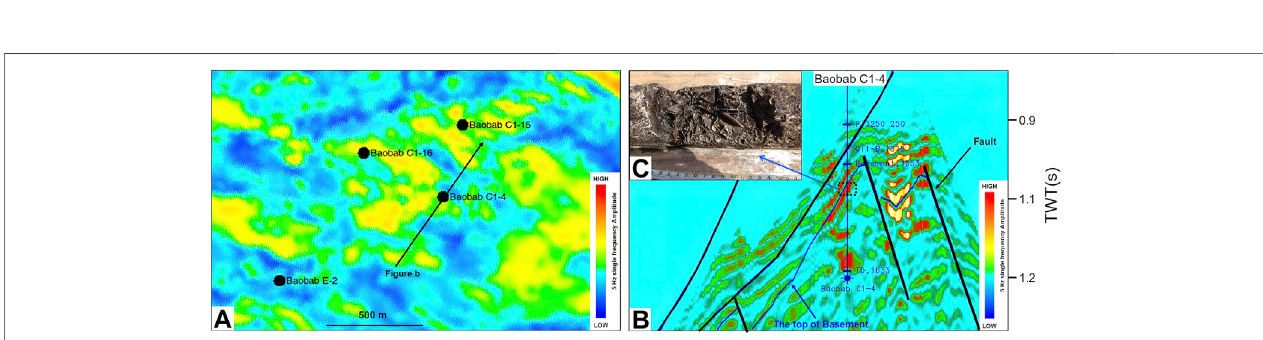
FIGURE7|(A) Planviewofthesingle-frequency volume intheareaofwellBaobabC1-4 (5 Hz). (B) Single-frequencypro fi le ofwellBaobabC1-4. (C) Image ofthe core of well Baobab C1-4 (1,419.72 m – 1420 m).